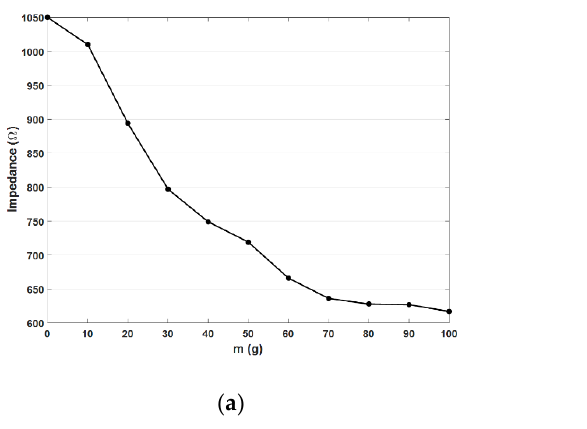
Figure 1. The force–impedance relation for the sensor consisting of fCNT and SA composite ( a ) not including glycerin and ( b ) including glycerin .